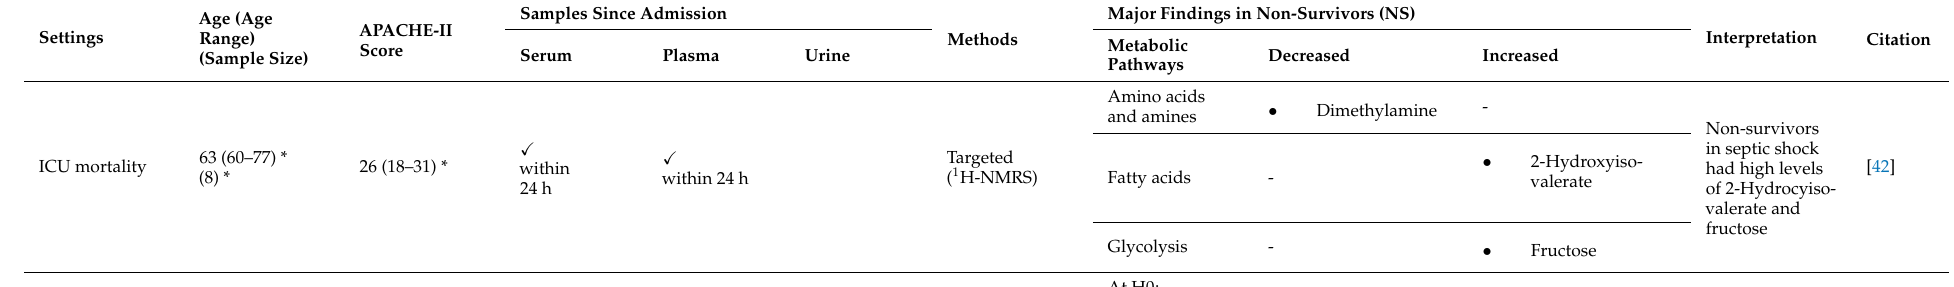
Table 4. Metabolomics-assisted prognostication of patients with septic shock